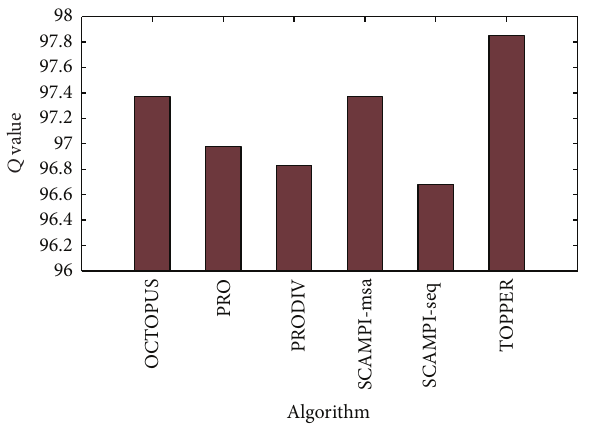
F 5: e comparison of transmembrane region’s prediction performance between the proposed method and other algorithms.